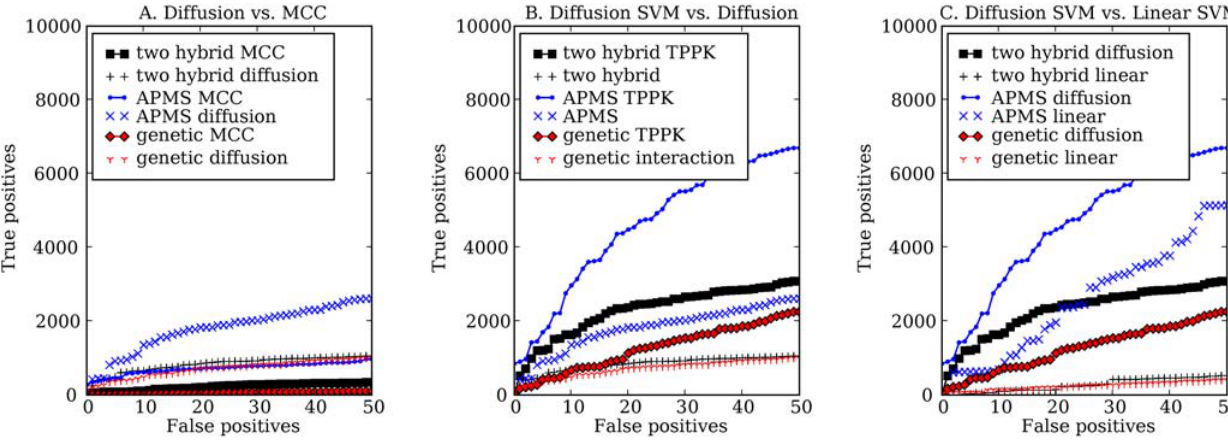
Figure 1. The ROC 50 performance of the TPPK of diffusion kernels. (A) compares the ROC 50 scores from ranking directly based on diffusion kernel values and from ranking on hypergeometric MCCs. The ROC 50 scores of the TPPK of diffusion kernels are compared with (B) ranking directly on the diffusion kernel values and (C) the TPPK of linear kernels.